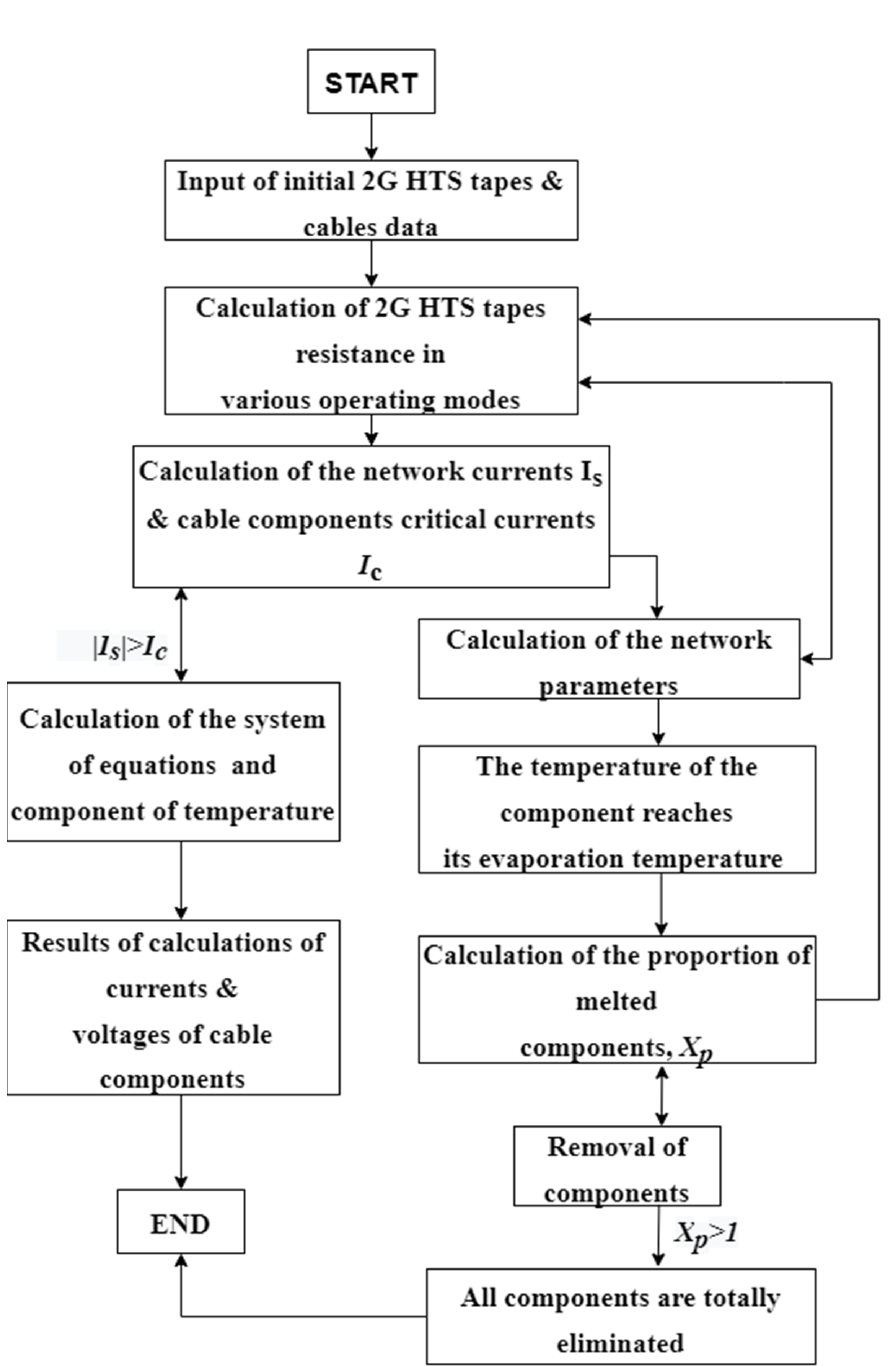
Figure 2. The block diagram of the calculations algorithm.